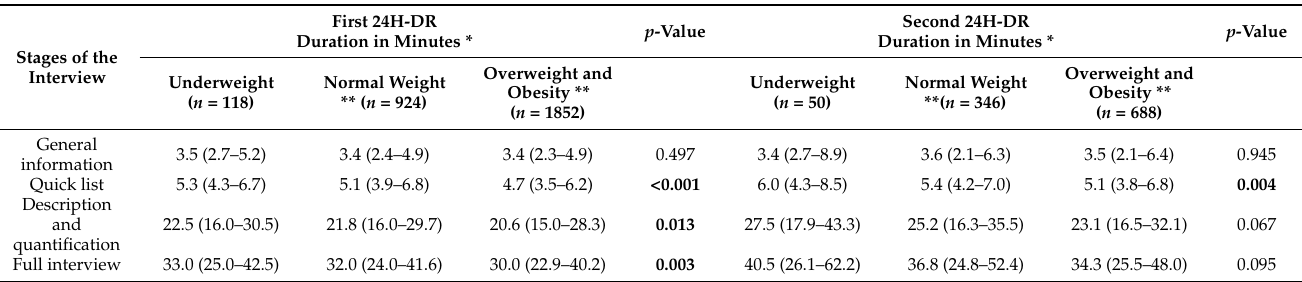
Table 6. Duration of the first (face-to-face) and second (preferably by telephone) 24H-DR measure- ment according to the nutritional status of participants in the third wave of the ELSA-Brasil study